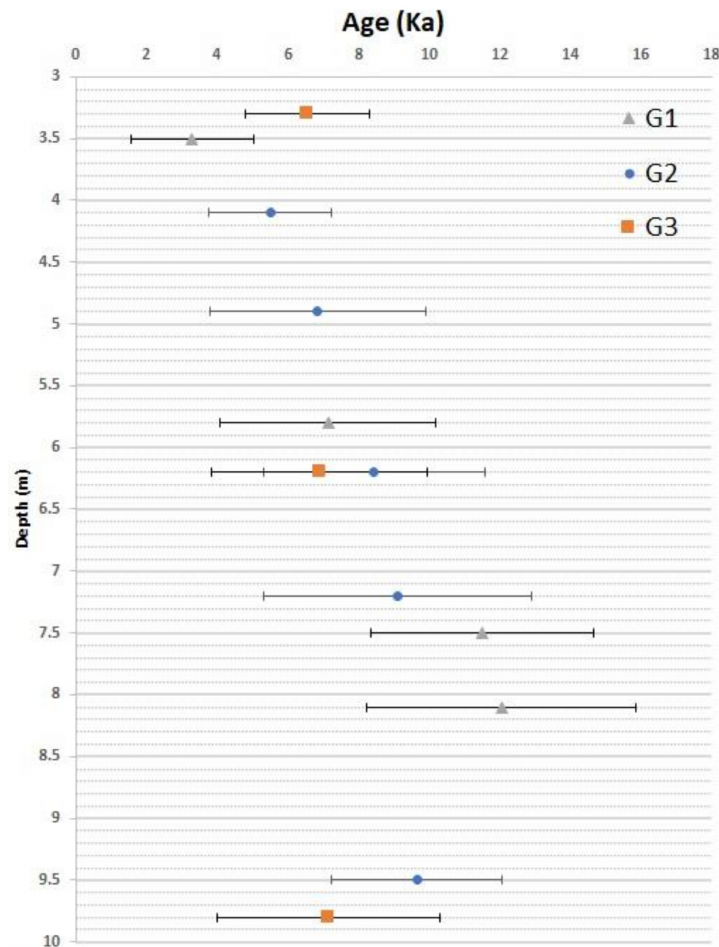
Figure 9. OSL ages with 1 σ errors vs. depth for samples.